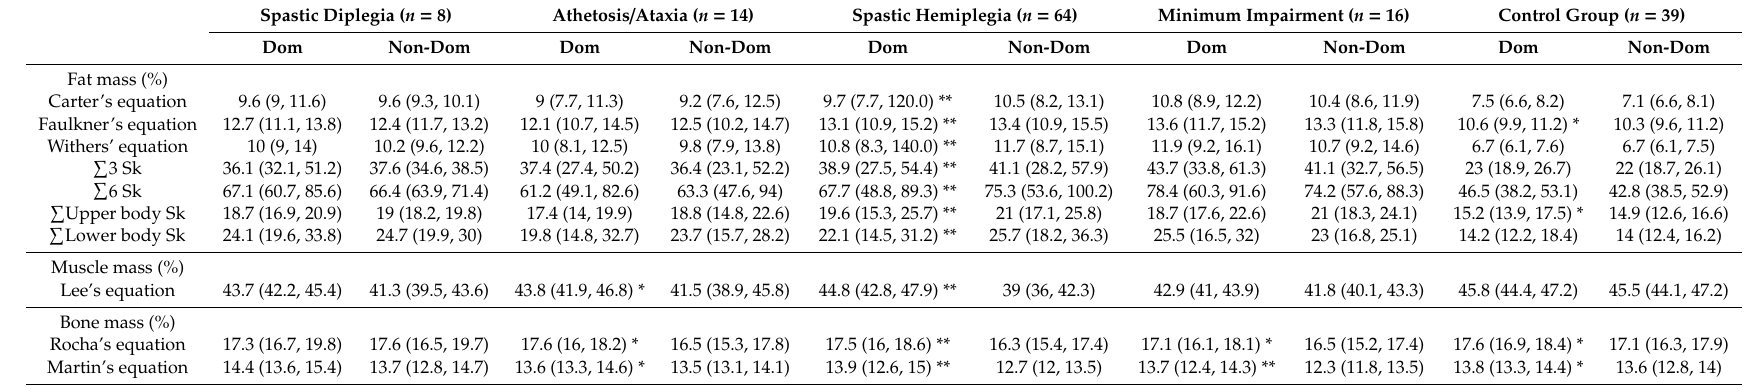
Table 3. Body composition of the four CP profiles and the able-bodied football players (control group). Spastic Diplegia ( n = 8) Athetosis / Ataxia ( n = 14) Spastic Hemiplegia ( n = 64) Minimum Impairment ( n = 16) Control Group ( n =